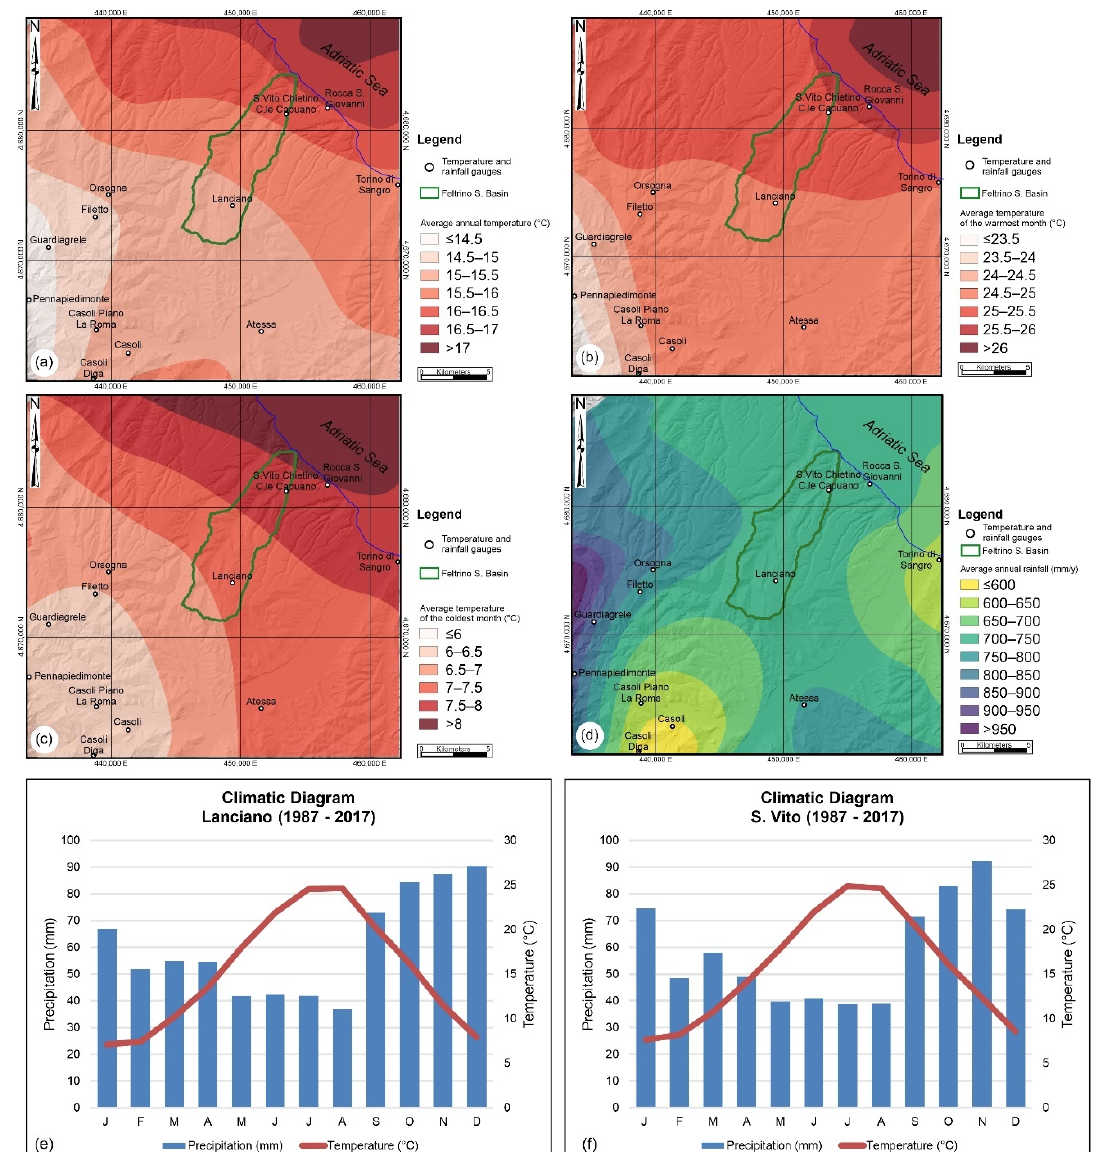
Figure 2. Climatic setting of the study area and the surrounding region. White dots in the map (realized through the Kernel Interpolation function) show the temperature and rainfall gauges, while the green line is the Feltrino Stream basin. ( a ) Average annual temperature; ( b ) average temperature of the warmest (July) month; ( c ) average temperature of the coldest (January) month; ( d ) average annual rainfall; ( e ) climatic diagram of the Lanciano gauge (1987–2017); ( f ) climatic diagram of the S. Vito–C.le Capuano gauge (1987–2017).